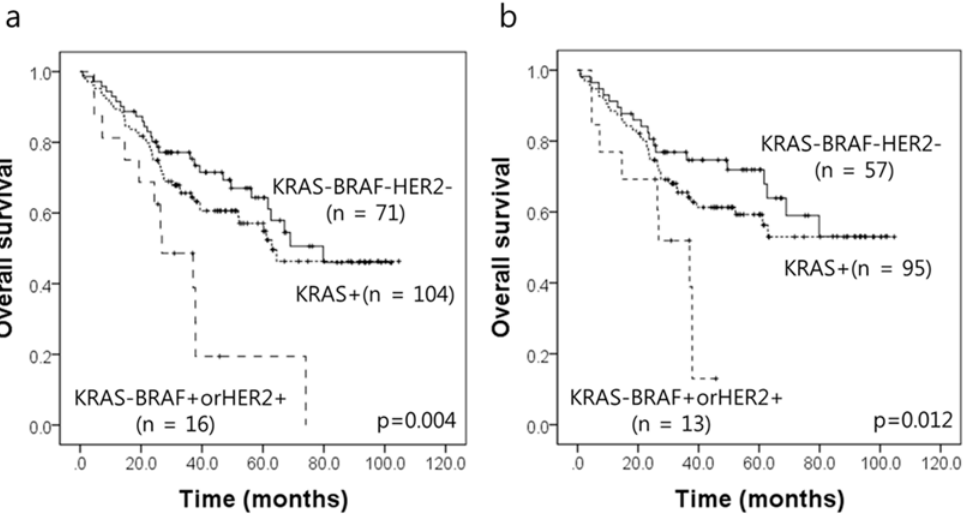
Fig 2. Results of combined analysis in advanced CRC patients with the KRAS wild type subgroup according to BRAF mutation and HER2 amplification regardless of anti-EGFR treatment status (n = 191) (a), in whom were not treated with anti-EGFR drugs (n = 165)